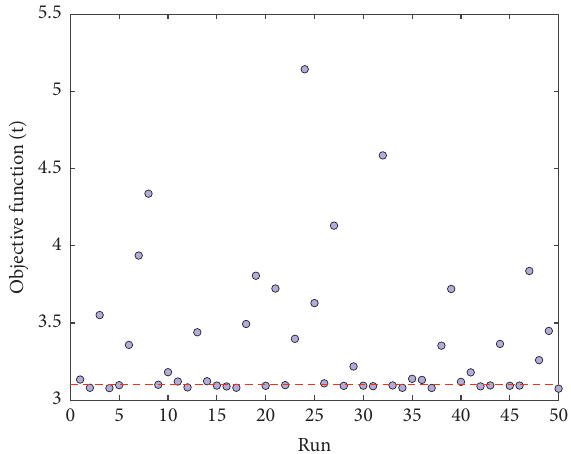
Figure 8: Structural example 2: Warren truss. Results from 50 times run